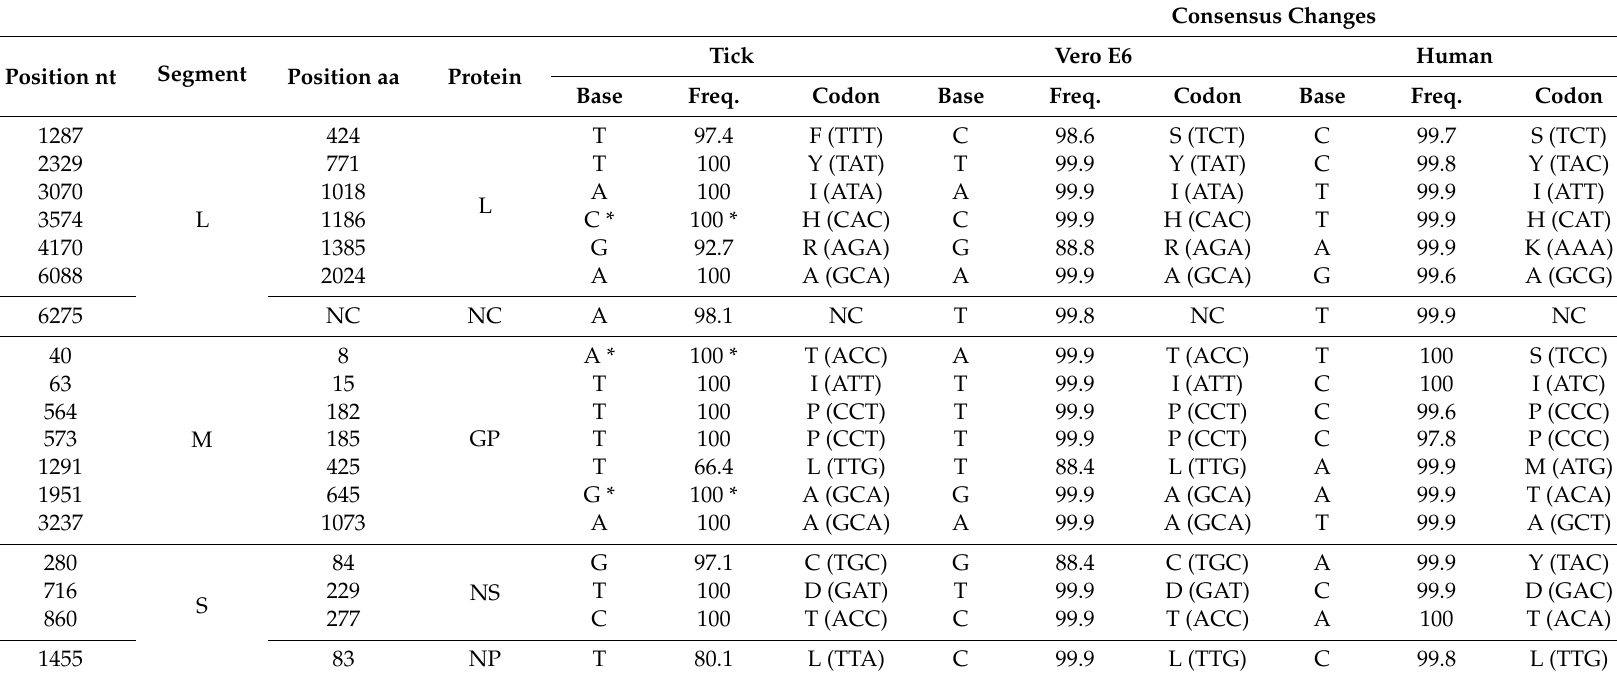
Table 4. Mutations (positions with nucleotide changes supported by > 50% of the reads) in the SFTSV populations from the Vero E6 isolate and from the SFTS case in relation to the virus from the ticks. Position nt / Position aa: nucleotide / amino acid position in the virus from the ticks; RdRp: RNA-directed RNA polymerase; GP: glycoprotein; NS: nonstructural protein; NP: nucleocapsid protein; NC: non-coding; Freq.: percentage of reads supporting the corresponding nucleotide; Codon: amino acid residue and the corresponding codon. Bases with and asterisk (*) in the virus from the ticks were supported by less than 100 reads, and the values are shown for comparison purposes. Nucleotide and amino acid mutations in the Vero E6 isolate and in the virus from the SFTS case are shown in